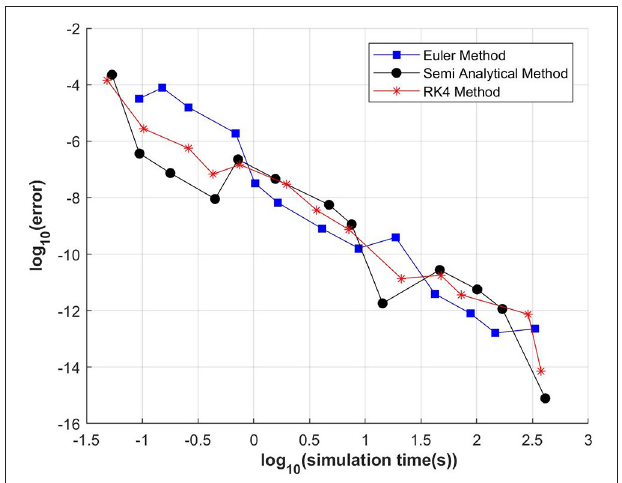
FIGURE 1 | Simulation times vs. error for three methods: EM, SAM, and modified RK4M. Results varying dt from 10 − 4 to 10 − 7 are